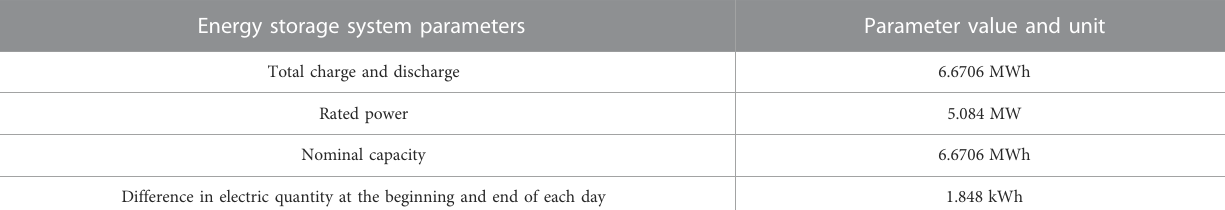
TABLE 2 Energy storage system con fi guration parameters.